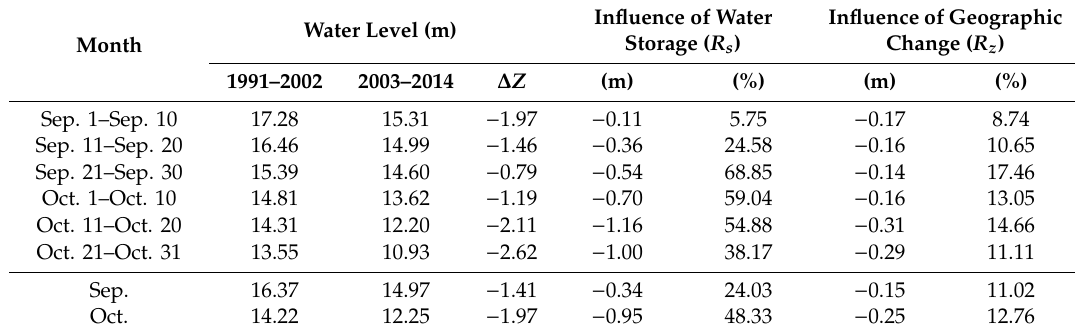
Table 2. Quantitative analysis of the factors of water level decrease in September and